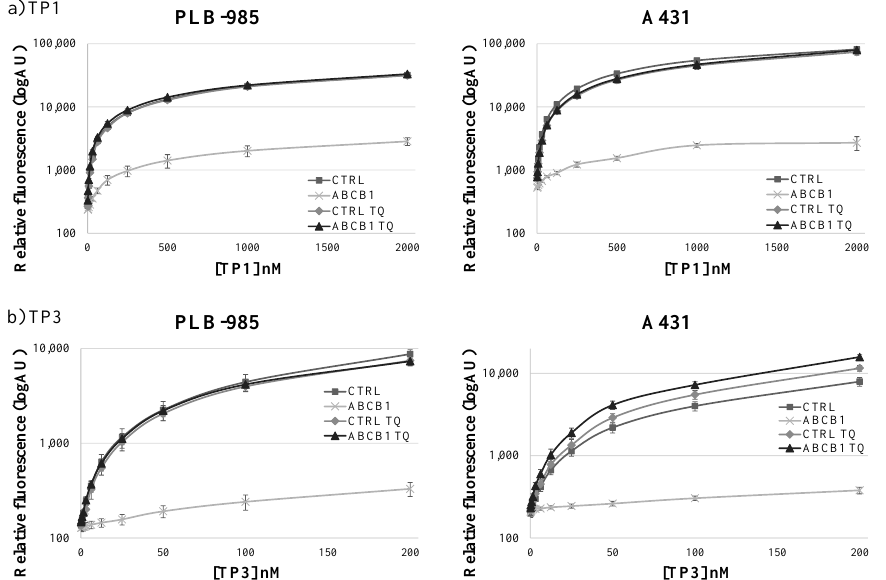
Figure 2. Concentration dependence of TP1 ( a ) or TP3 ( b ) dye uptake in PLB-985 and A431 control cells and in those overexpressing ABCB1. The CTRL ( ■ ) and ABCB1-expressing (×) cells were incubated with increasing concentrations of the dyes at 37 ◦ C, for 24 h. The rhombuses ( ♦ : CTRL) and the triangles ( (cid:78) : ABCB1) demonstrate TP1 or TP3 accumulation in the presence of 250 nM TQ, a specific ABCB1 inhibitor. Dead cells were identified on the basis of rapid TP3 dye (for TP1) or PI staining (for TP3). +/ − SD values are indicated ( n = 3).